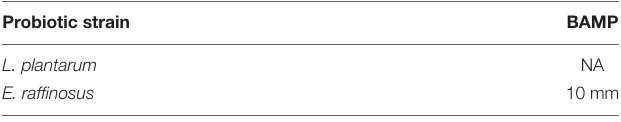
TABLE 3C | The activity of the purified antimicrobial compound against probiotic microbes. The activity was expressed as a zone of inhibition. Probiotic